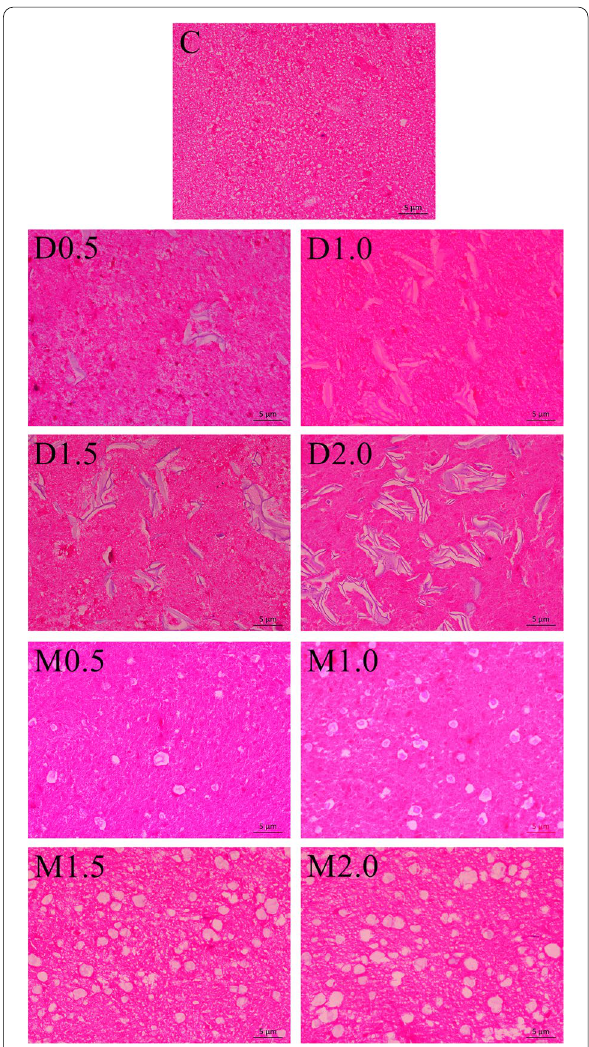
Fig. 3 Paraffin section of composite MP gels with modified starch and dietary fiber. C: The control; D0.5: MP with 0.5% modified starch; D1.0: MP with 1.0% modified starch; D1.5: MP with 1.5% modified starch; D2.0: MP with 2.0% modified starch; M0.5: MP with 0.5% dietary fiber; M1.0: MP with 1.0% dietary fiber; M1.5: MP with 1.5% dietary fiber; M2.0: MP with 2.0% dietary